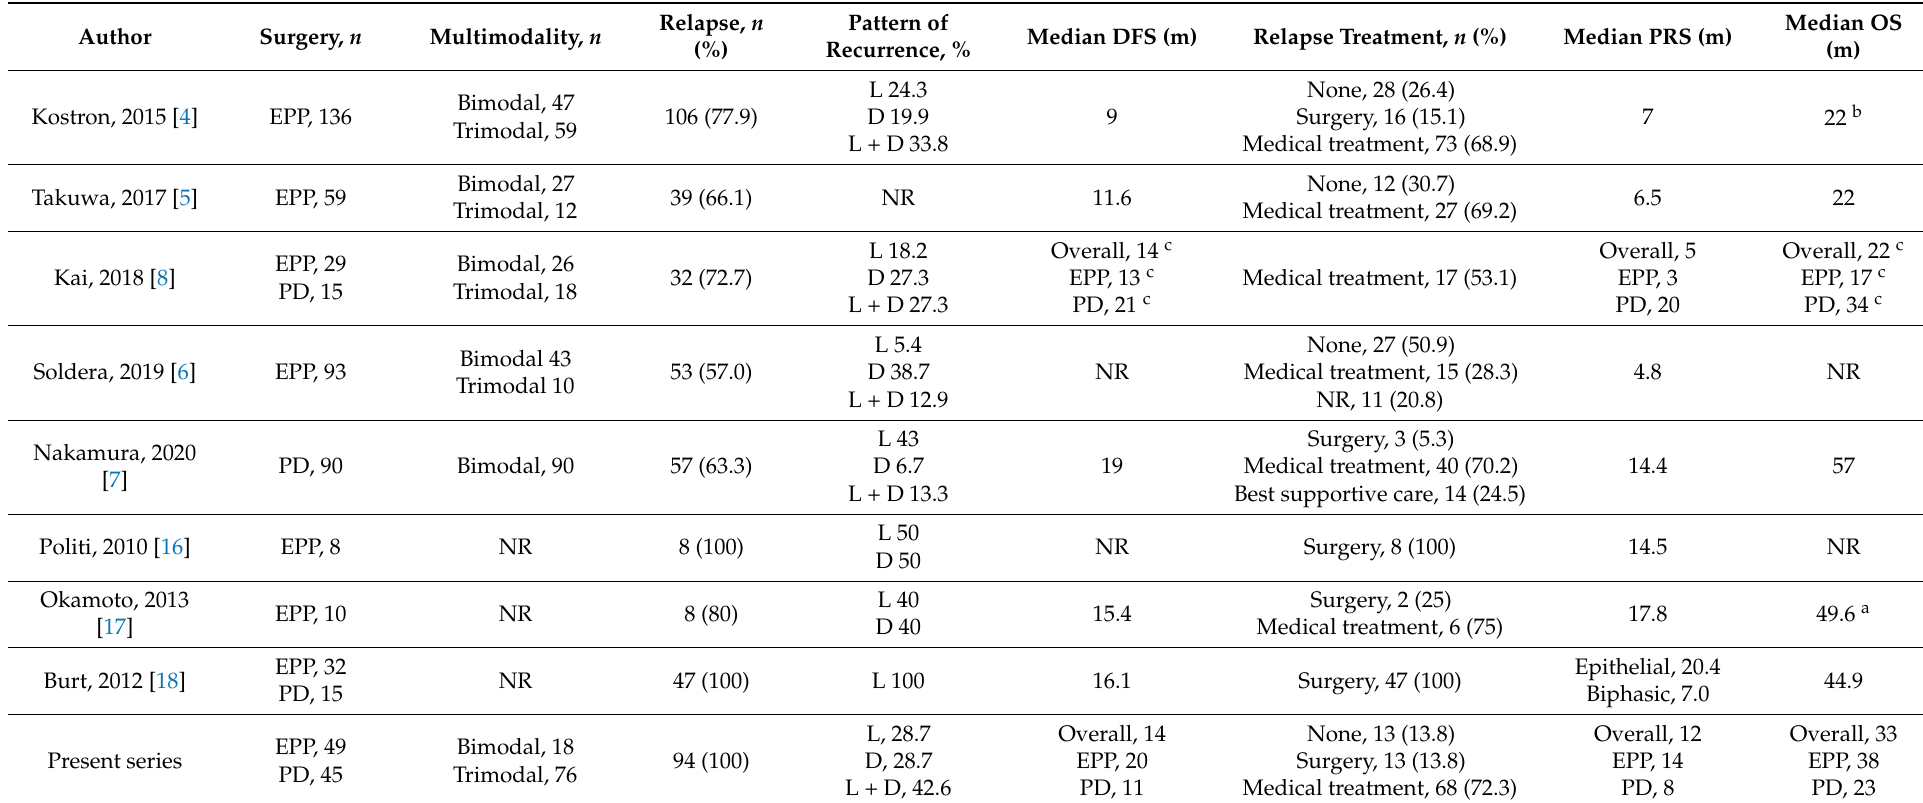
Table 4. Major studies about the treatment of recurrent